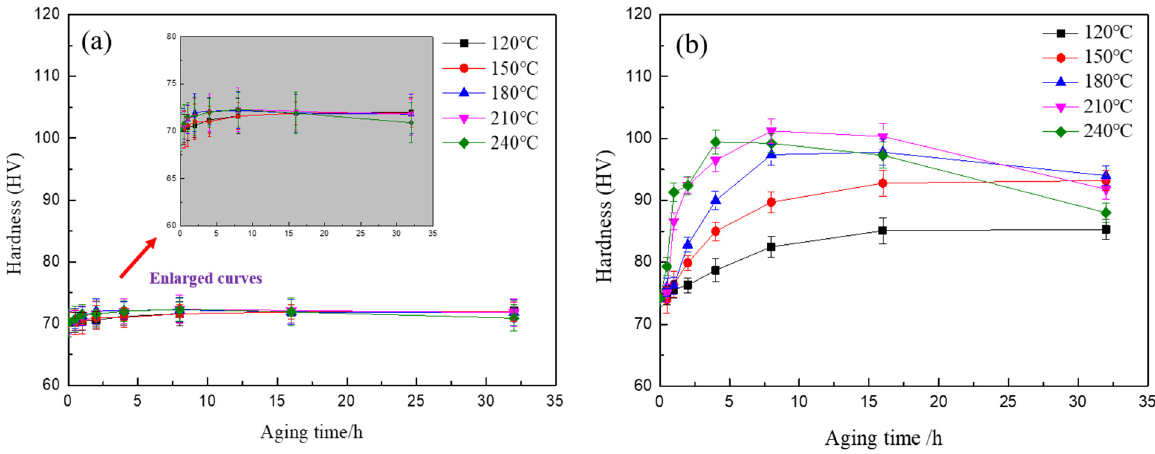
Figure 3. Hardness curves of ( a ) Al-4Mg alloy, ( b ) Al-4Mg-0.6Ag alloy aging at different temperatures.